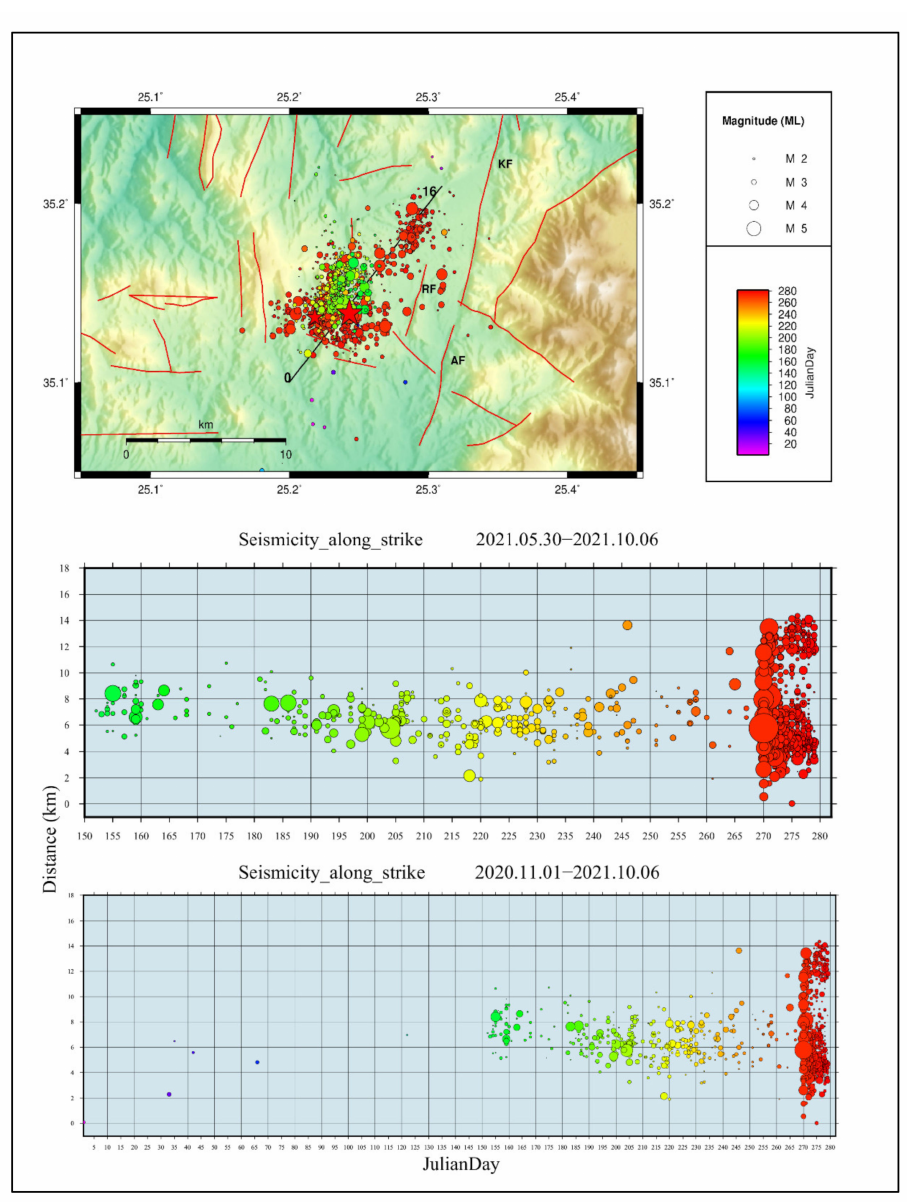
Figure 5. ( top panel) Map showing the relocated seismicity record around Arkalochori, ( middle panel) events are projected on time vs distance section from 1 November 2020 to 6 October 2021, ( bottom panel) from 30 May to 6 October 2021. Colour of events corresponds to the Julian day of